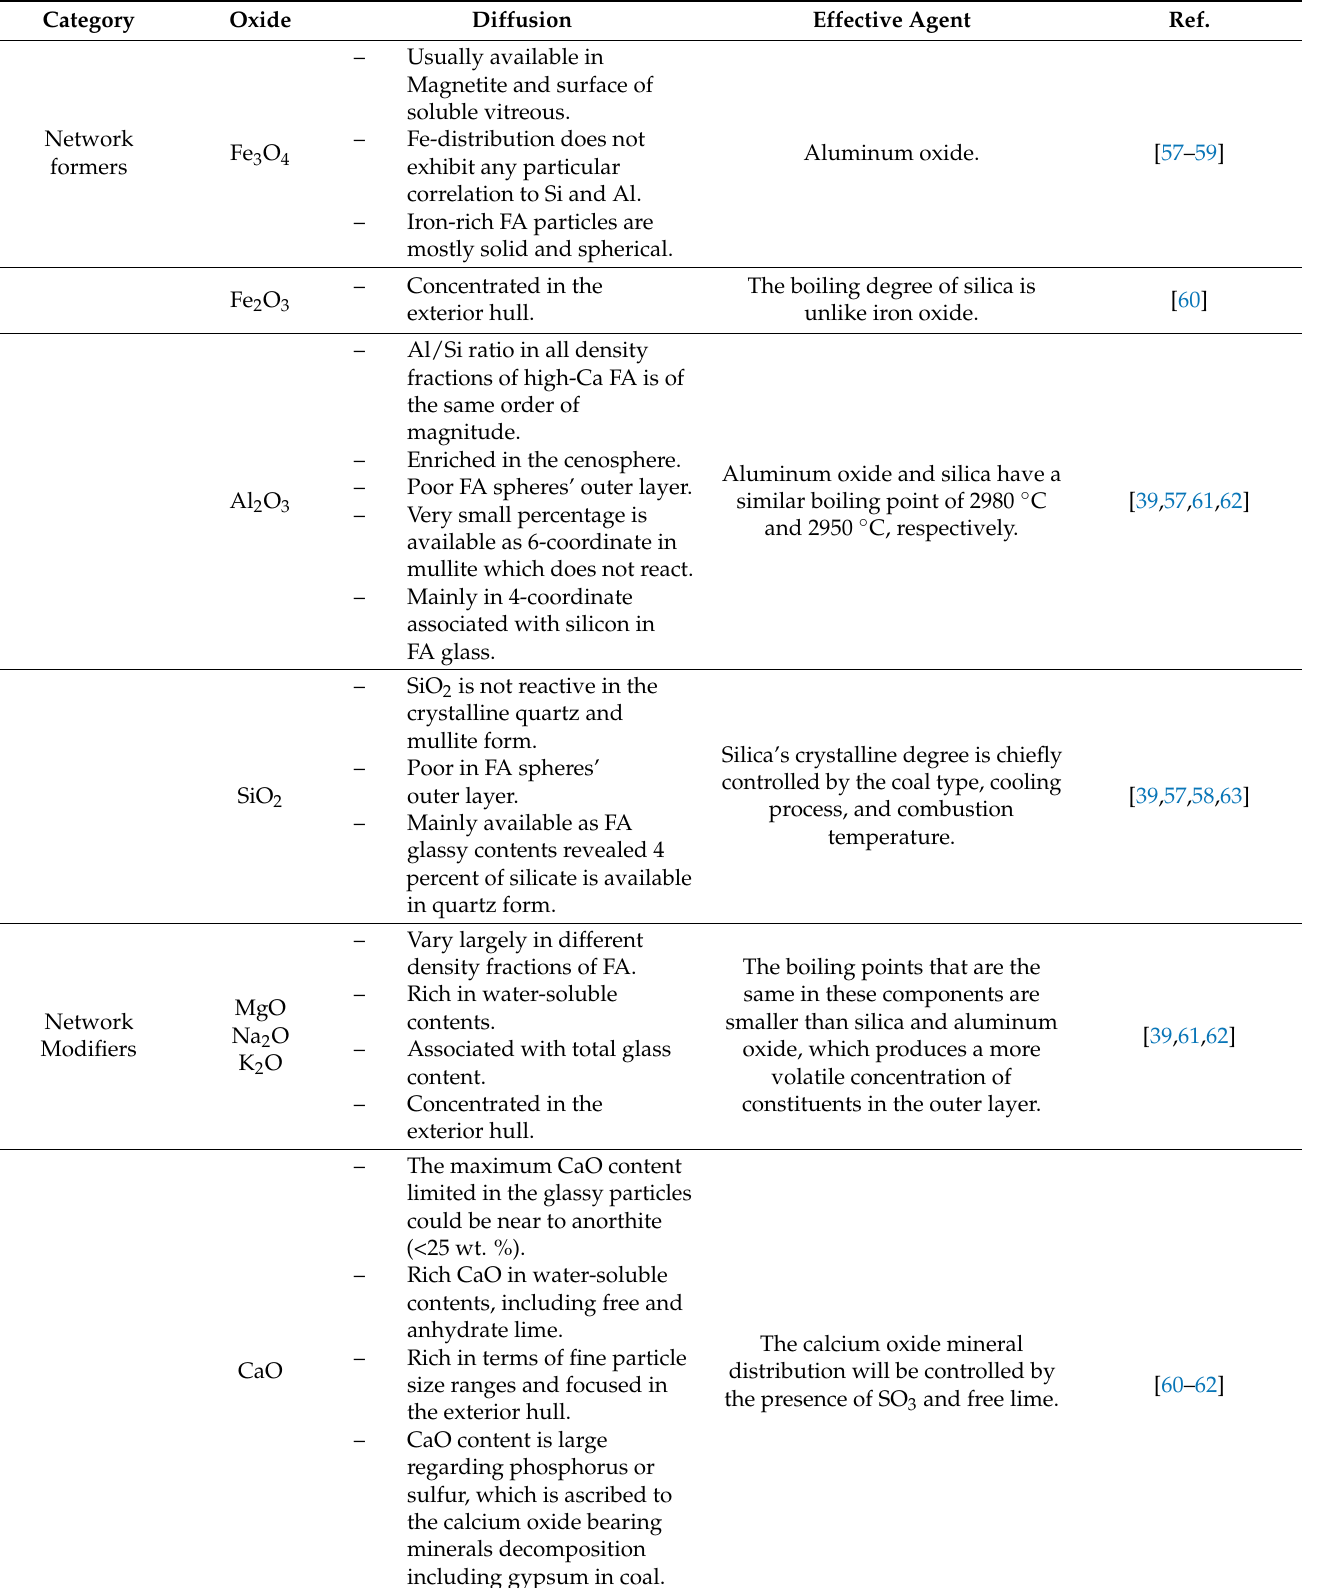
Table 3. Distribution of characteristics of different oxides production technique of FA. Category Diffusion Effective Agent